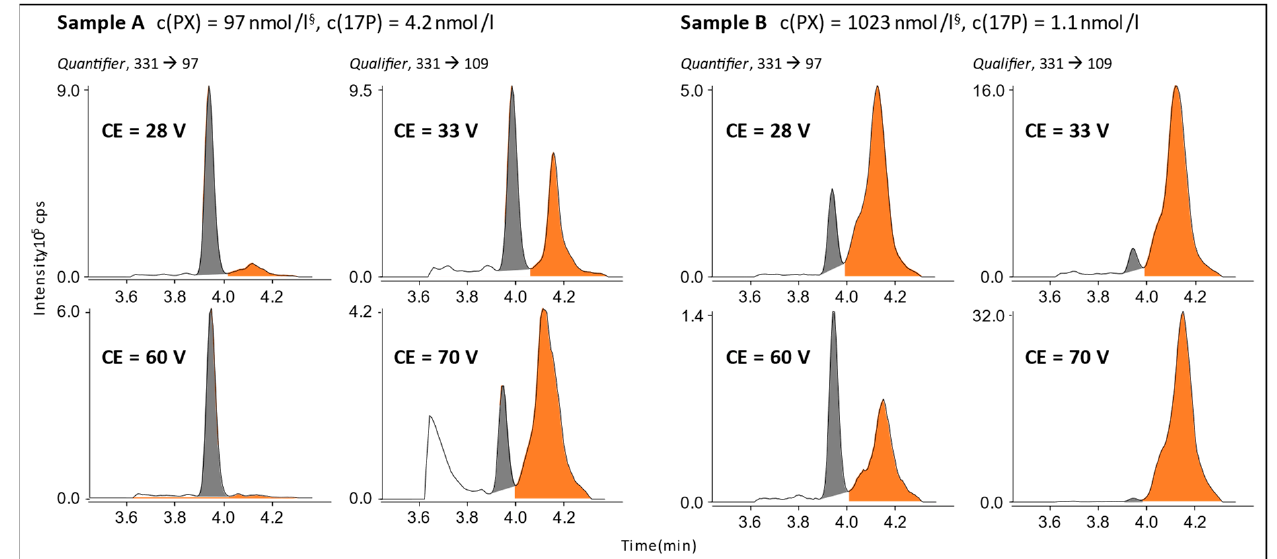
Figure 2. Effect of a raise in collision energy (CE) for the quantifier and qualifier mass transition of 17P on the signal intensities of 17P (grey) and PX (orange) in patients’ samples with known PX concentrations. § PX concentration was measured during routine TDM testing using an IVD-CE- certified LC-MS/MS